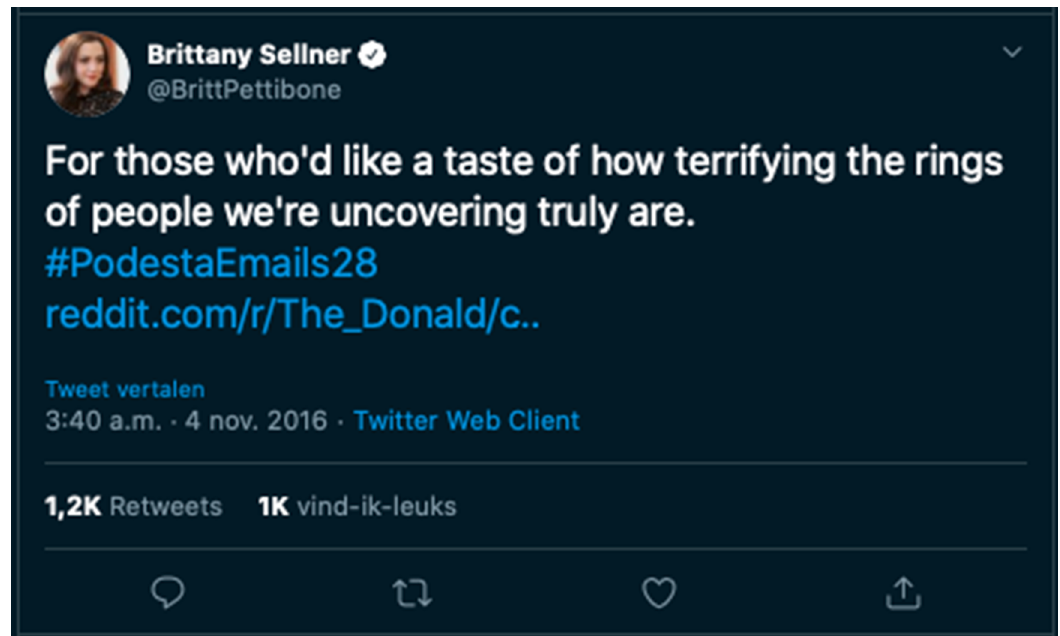
Figure 3. First “Podesta” tweet form Pettibone.